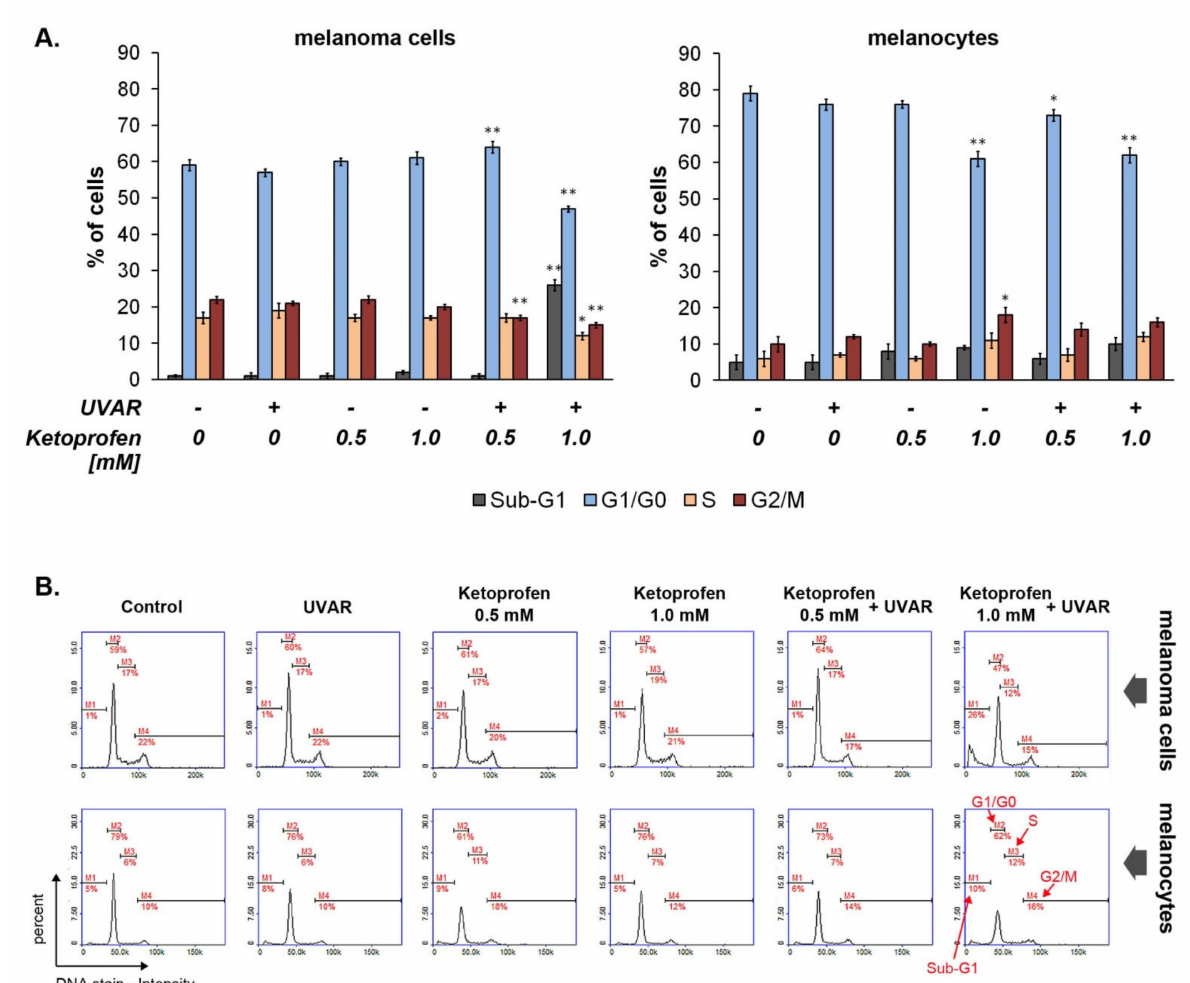
Figure 4. Effect of KTP and UVAR on cell cycle in melanoma cells and human melanocytes. ( A ) Bar graphic representing mean values ± SD of three independent experiments performed in at least three repetitions; * p < 0.05, ** p < 0.001 vs. control. ( B ) Representative histograms showing the cell cycle distribution (one-way ANOVA, two-way ANOVA, Tukey’s